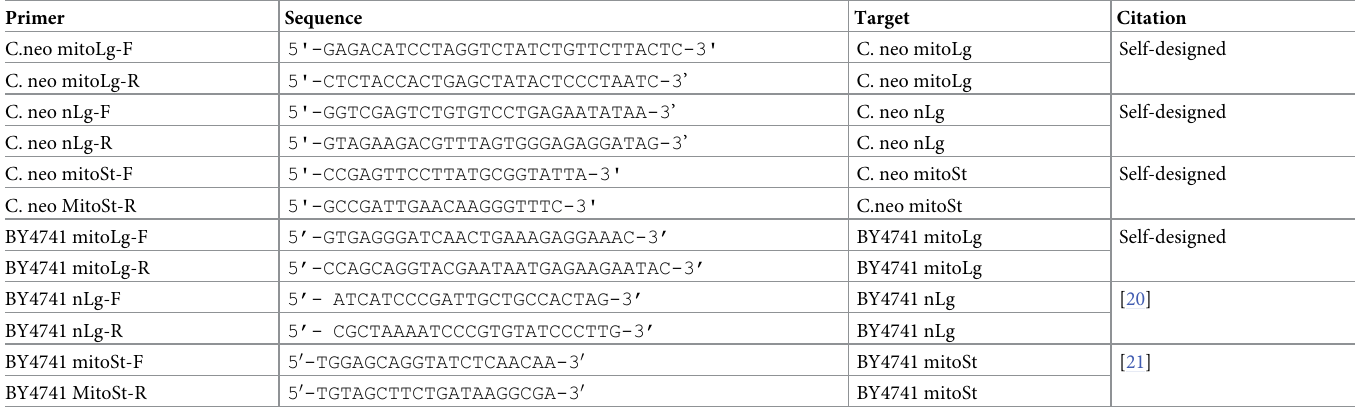
Table 1. The primer sequences used in the